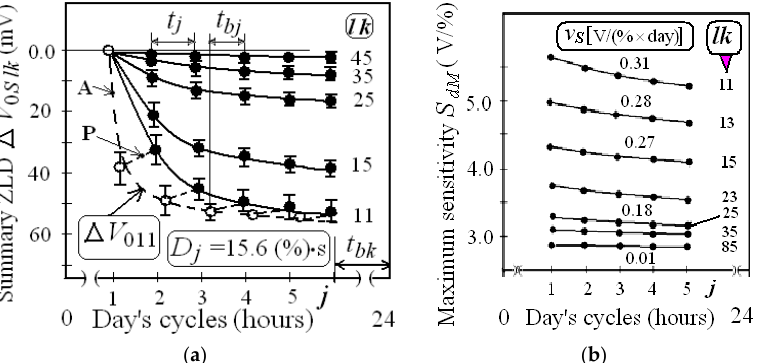
Figure 5. Changes in response parameters during lk -cycles on different days: ( a ) Summary ZLD changes, A and P are active and passive ZLD stages; ( b ) Maximum differential sensitivity S dM .